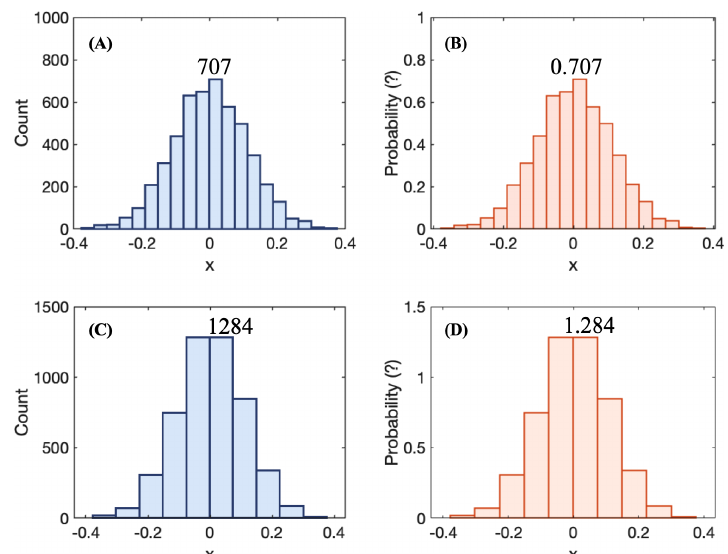
Figure A1. Histograms of particle positions for 1000 particles. ( A ) counts using 20 bins; ( B ) counts from ( A ) divided by total number of particles; ( C ) counts using 10 bins; ( D ) counts from ( C ) divided by total number of particles.